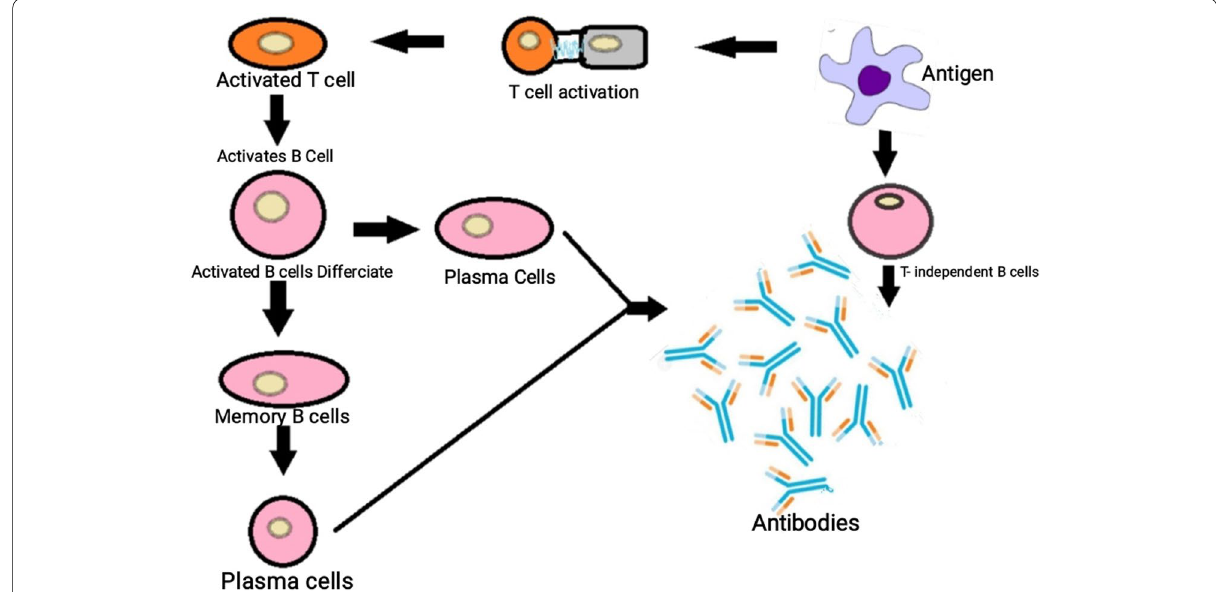
Fig. 2 Activation of B cells and production of